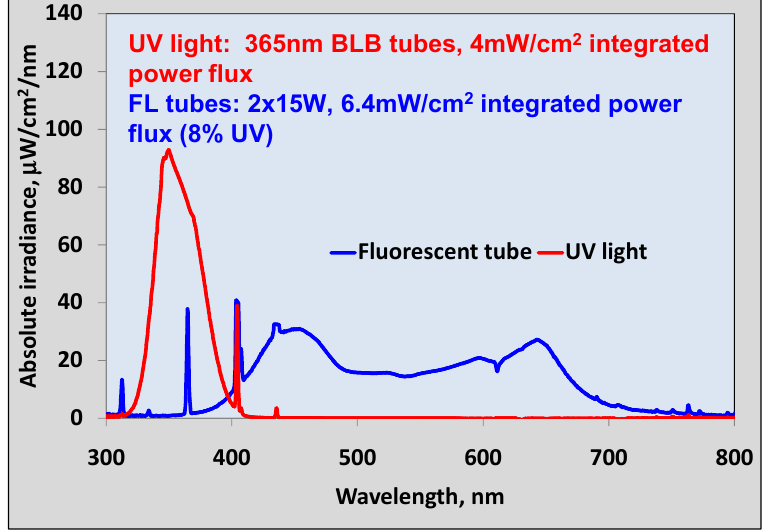
Figure 1. Spectra from UV and fluorescent tubes used for photocatalytic testing, measured at 100 mm from the light